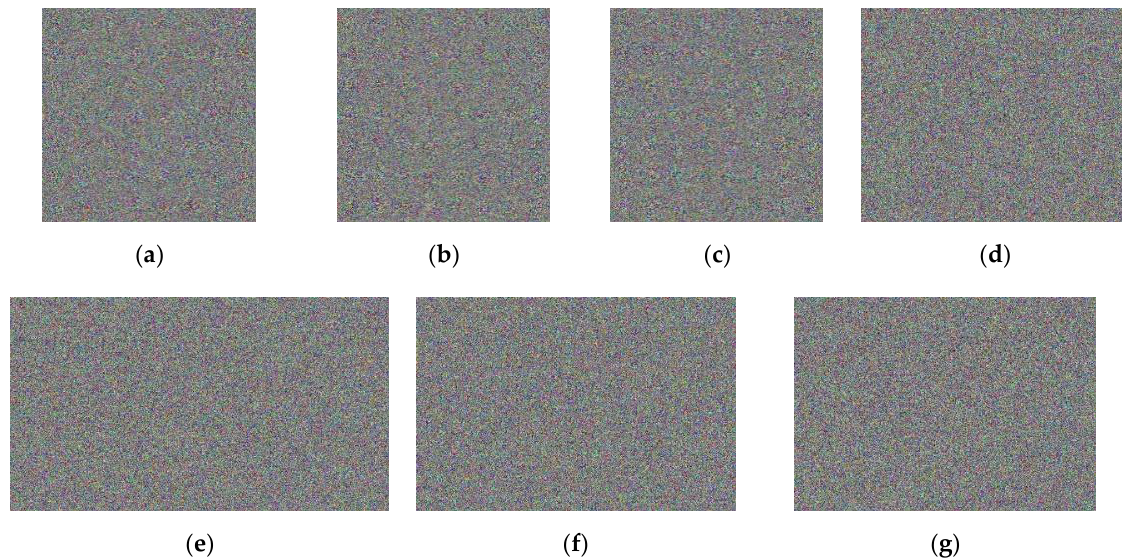
Figure 4. Images after encryption: ( a ) Lena_encrypted.jpeg, ( b ) Babbon_encrypted.jpeg, ( c ) Boat_ encrypted.jpeg, ( d ) Barbara_ encrypted.jpeg, ( e ) City_ encrypted.jpeg, ( f ) House_ encrypted.jpeg, ( g ) Security_ encrypted.jpeg.